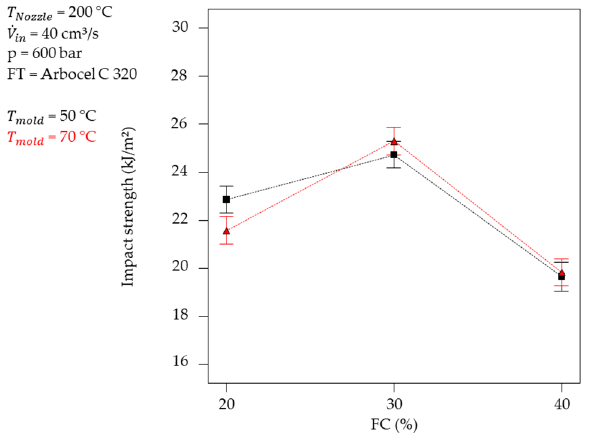
Figure 7. Detected notched impact strength of wood ‐ filled TPU as a function of mold temperature.